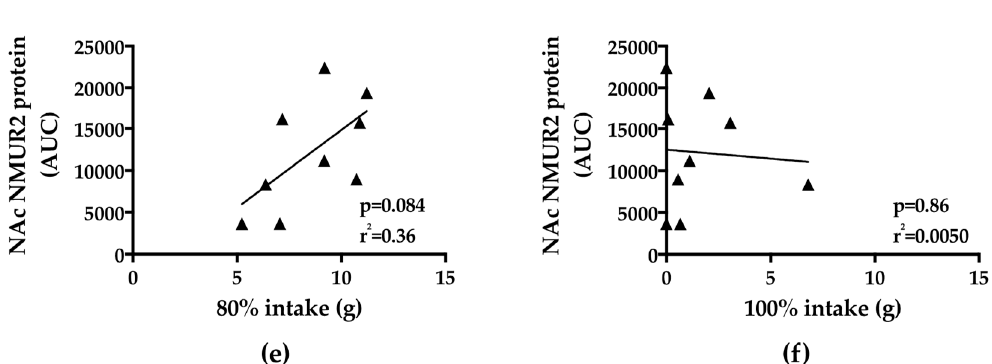
Figure 3. NAc NMUR2 protein expression was positively correlated with binge-type eating. ( a ) representative Western blot image for NMUR2 synaptosomal protein from NAc samples; ( b ) NAc NMUR2 expression was positively correlated with intake of a 20% fat (80% carbohydrate) mixture; ( c ) NAc NMUR2 expression was positively correlated with intake of a 40% fat (60% carbohydrate) mixture; ( e ) NAc NMUR2 expression was not correlated with intake of a 60% fat (40% carbohydrate) mixture; ( f ) NAc NMUR2 expression was not correlated with intake of an 80% fat (20% carbohydrate) mixture; ( g ) NAc NMUR2 protein expression was not correlated with intake of a 100% fat (0% carbohydrate) mixture. AUC: area under the curve. * p < 0.05.